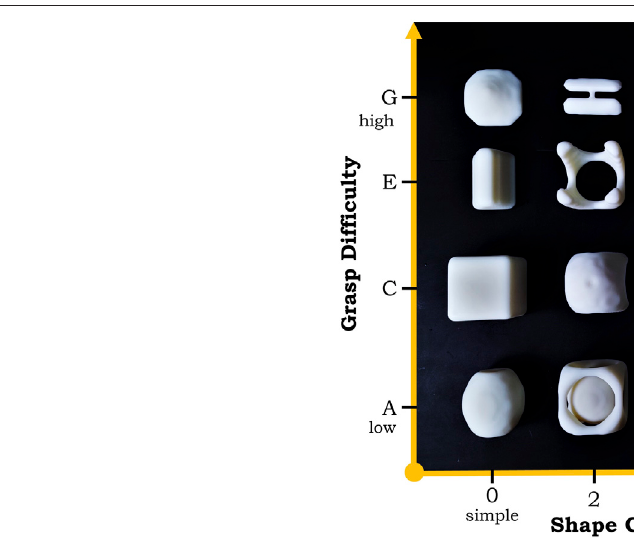
Frontiers in Robotics and AI |